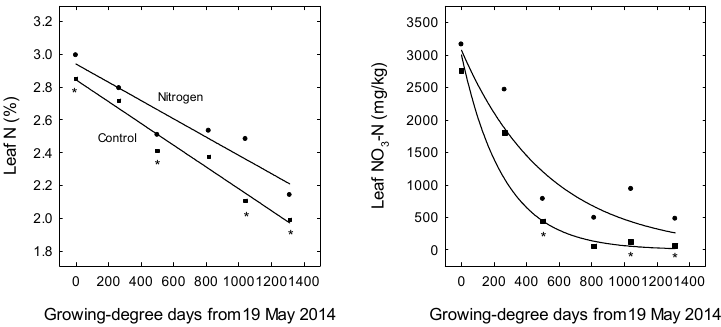
Figure 2. Effect of nitrogen (N) on changes in the concentration of total N and nitrate-N (NO 3 -N) in young, fully expanded leaves of strawberry plants grown in Queensland, Australia in 2014. Data are pooled over three cultivars (‘Festival’, ‘Fortuna’, and ‘Winter Dawn’). Each symbol represents the mean of 12 replicates. Paired means with an asterisk are significantly different at p = 0.05. Control: leaf N = 2.84 − 0.0007 × GDD ( R 2 = 0.95) and leaf NO 3 -N = 3003 × exp. ( − 0.0038 × GDD) ( R 2 = 0.87). Nitrogen treatment: leaf N = 2.94 − 0.0006 × GDD ( R 2 = 0.86) and leaf NO 3 -N = 3075 × exp. ( − 0.0019 × GDD) ( R 2 = 0.70). Calculation of growing-degree days (GDDs) was based on a base temperature of 7 °C.